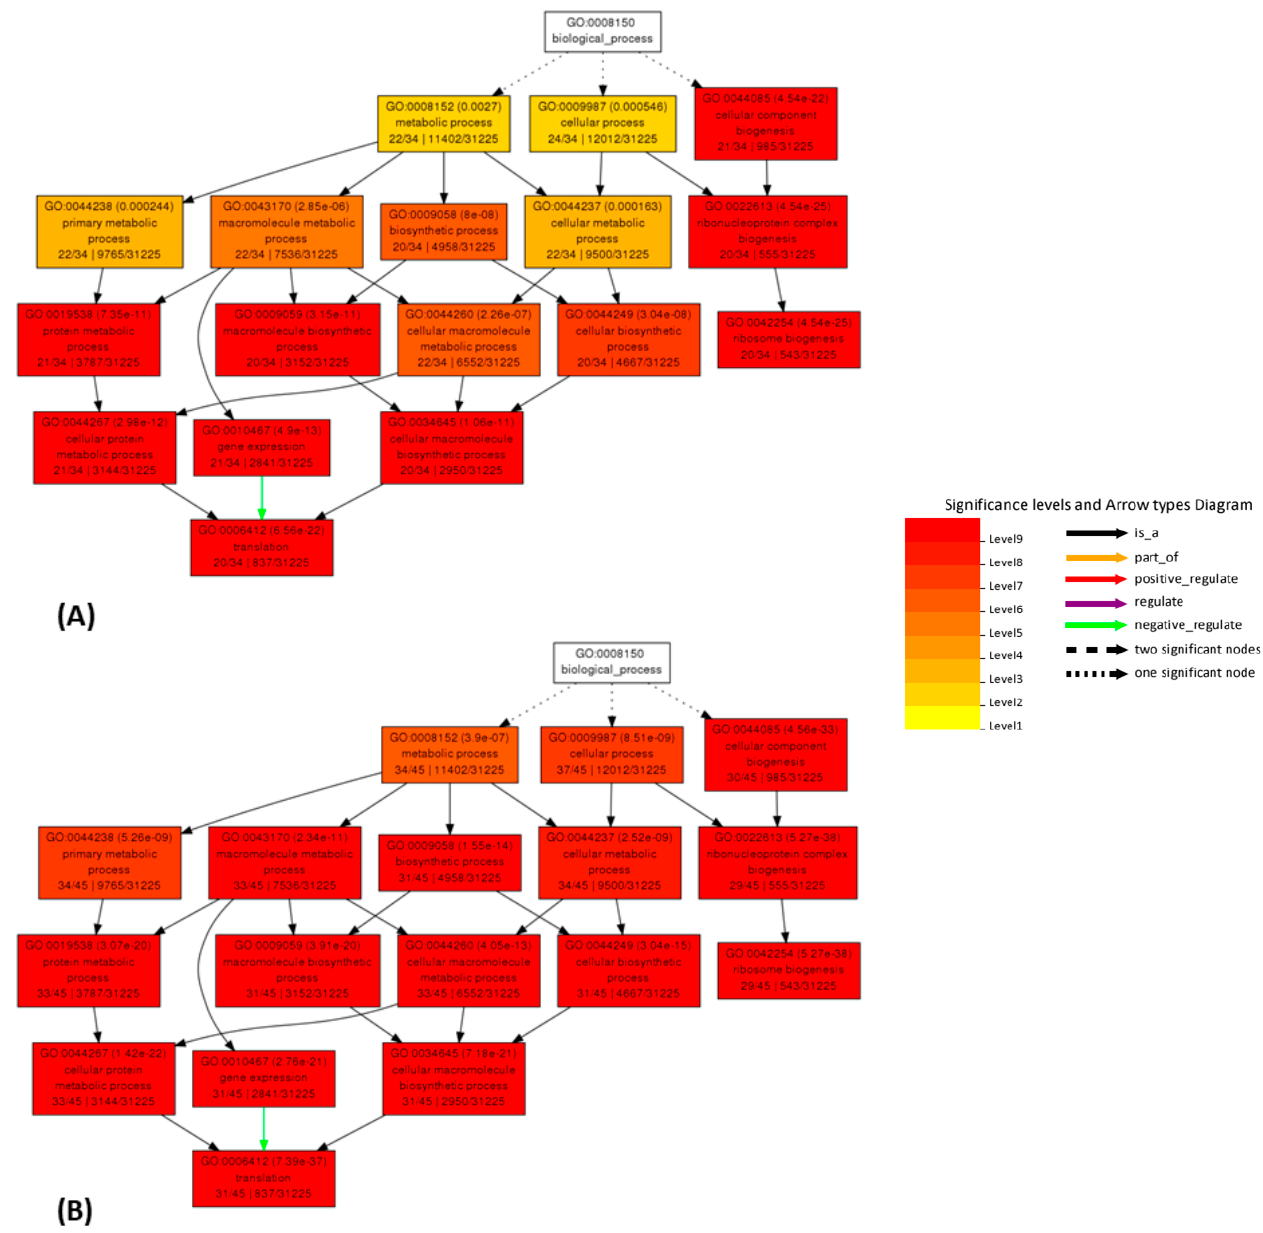
Figure 6. Comparison of AgriGO enrichment analysis working with logarithmic co-expression data for the Mtr.12230.1.S1_at gene (Table S17B). Results obtained from correlation values from the original ( A ) and cleaned ( B ) da- taset.